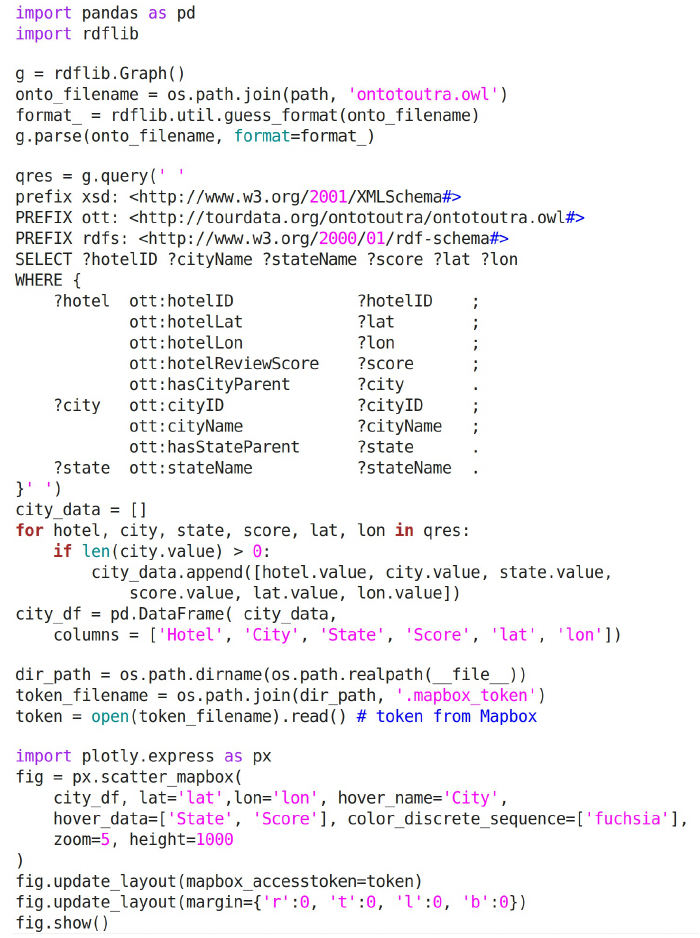
Figure 12. Example of ontology visualization: Main tourist destinations in